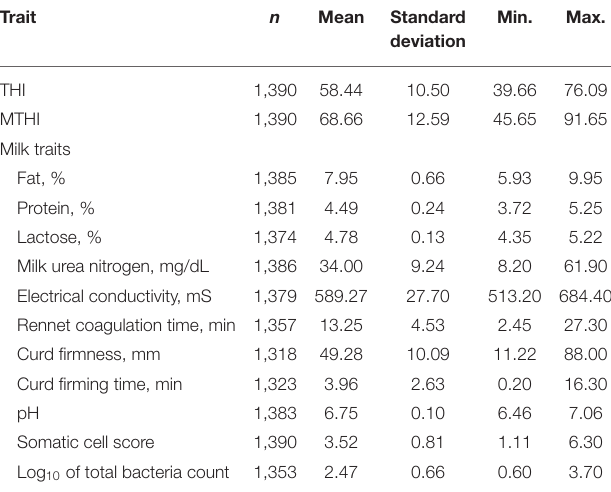
Statistical Analysis TABLE 1 | Descriptive statistics of temperature-humidity index (THI), maximum of temperature-humidity index (MTHI), and milk traits in the whole dataset. Trait n